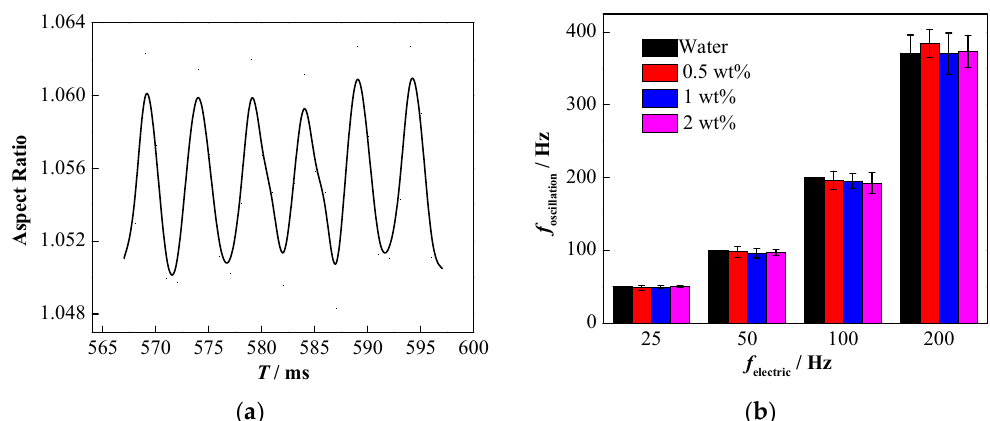
Figure 9. Influence of electric field frequency on the oscillatory deformation of nanoparticle-laden droplets (The RMS of electric field intensity is 192 kV·m −1 , and the frequency is 100 Hz). ( a ) Deformation of nanoparticle-laden droplets; ( b ) effect of electric field frequency on droplet oscillation frequency.